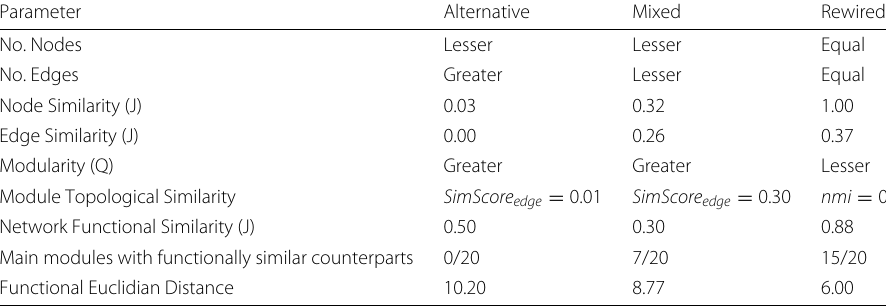
Table 11 Comparison of the modular structure of the Main network Parameter